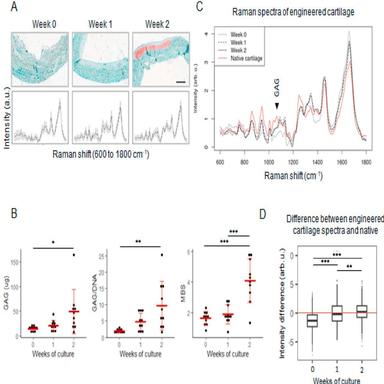
(A) Histological results (scale bar is 500 μm) and Raman spectra of engineered cartilages. (B) Biochemically quantified GAG, GAG/DNA, and histological MBS of engineered cartilage after zero, one, or two weeks of culture; bars indicate the mean and first standard deviation. (C) The average Raman spectrum of engineered cartilage at each time point, and the average native nasal cartilage spectrum. (D) Box plot of the sum of the engineered cartilage Raman spectra intensities at the peak maxima normalized to the